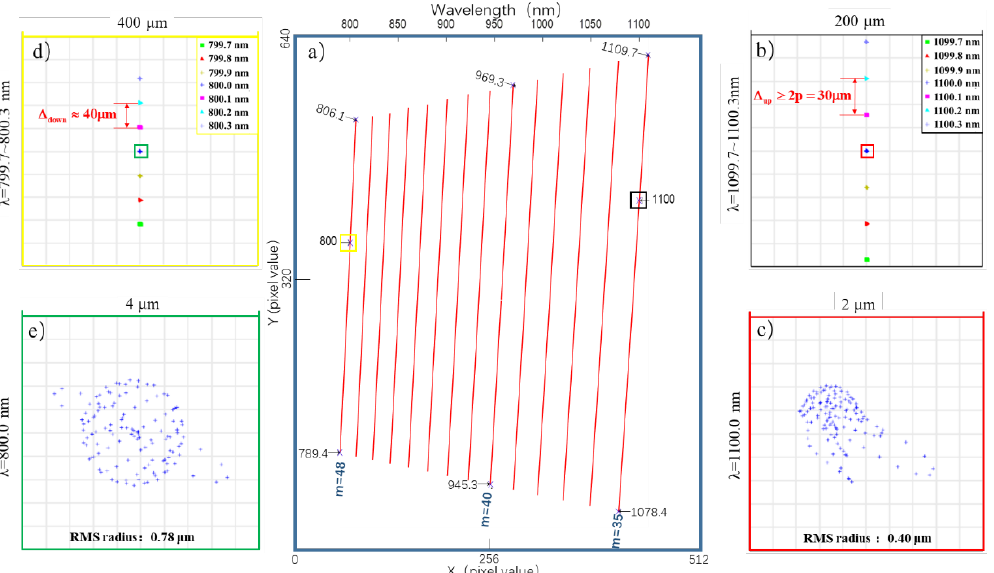
Figure 5. ( a ) Free spectrum of 14 orders on the 640 × 512 detector of channel 3. ( b , c ) Spot diagrams of the upper limit wavelength of 1100 nm and its vicinity. ( d , e ) Spot diagrams of the lower limit wavelength of 800 nm and its vicinity.